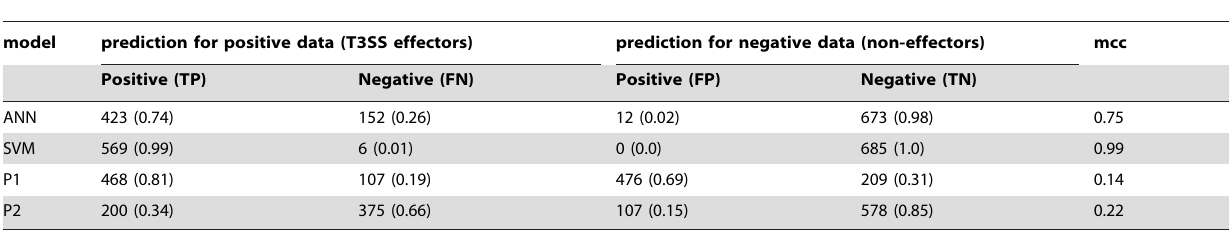
Table 1. Performance of the prediction systems and sequence patterns on the complete training data (re-classification).